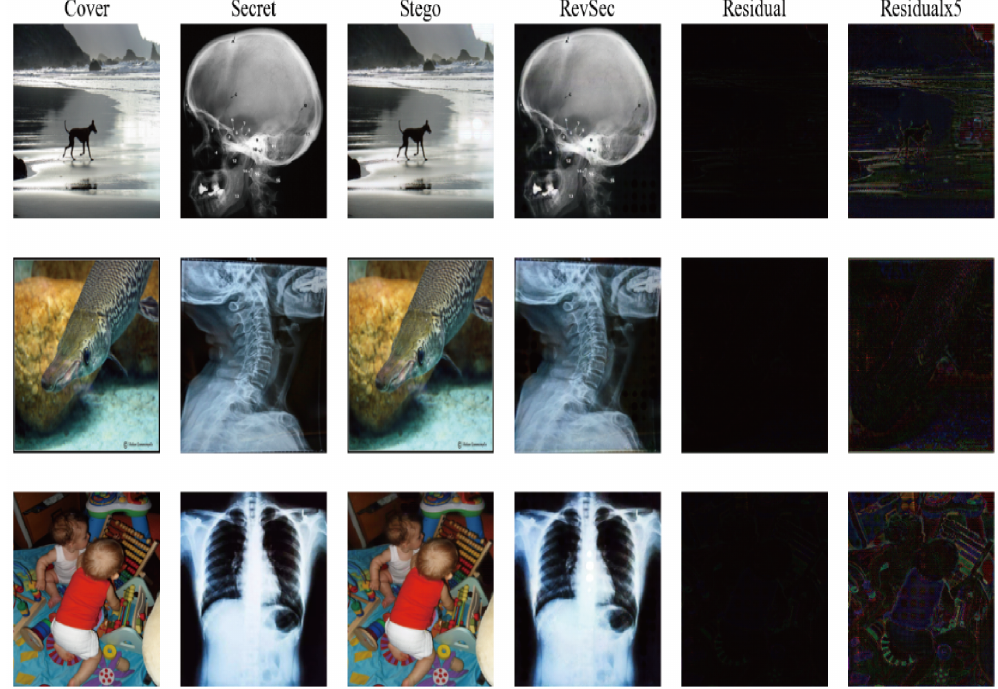
Figure 12. The test results of our proposed scheme on CT